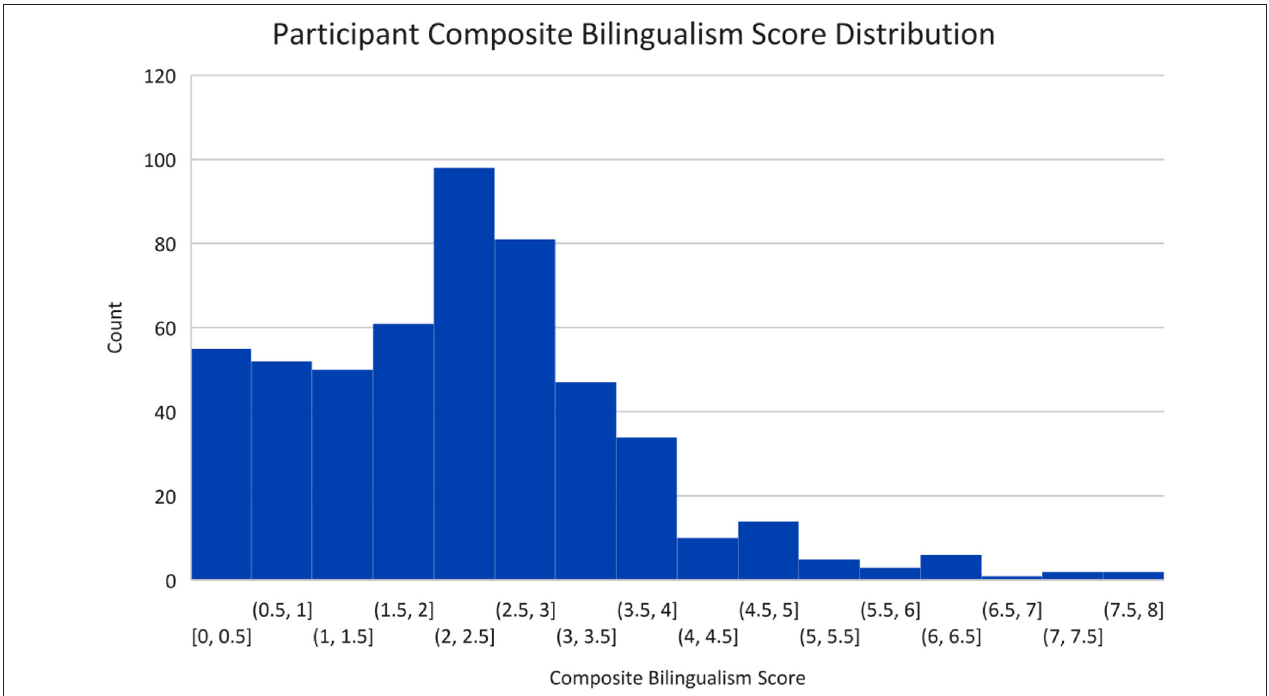
FIGURE 1 | Composite bilingualism scores (ranging from 0 to 8) derived from the LSBQ.